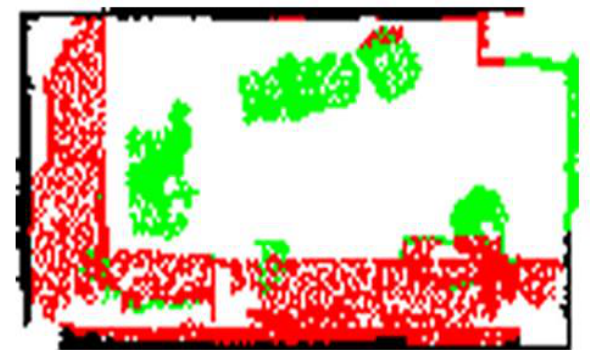
Fig. 5 The final obstacle element map